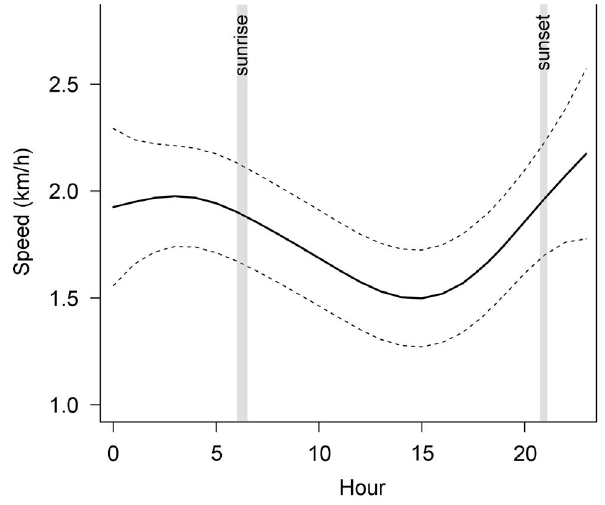
Figure 8. GAM estimate of ARS speed of blue whales during 24- hours in the Azores. Solid line represents the estimate and dashed lines the estimate 6 2 SE. Grey areas correspond to sunrise and sunset intervals (mean 6